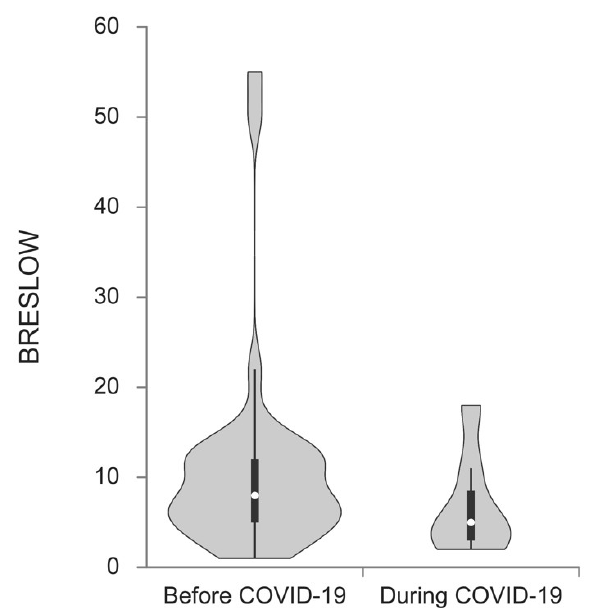
Figure 2. Breslow thickness median of melanoma patients diagnosed before and during the COVID- 19 pandemic. Patients diagnosed during the pandemic had a higher Breslow thickness median (1.80 vs. 3.00; p = 0.010).